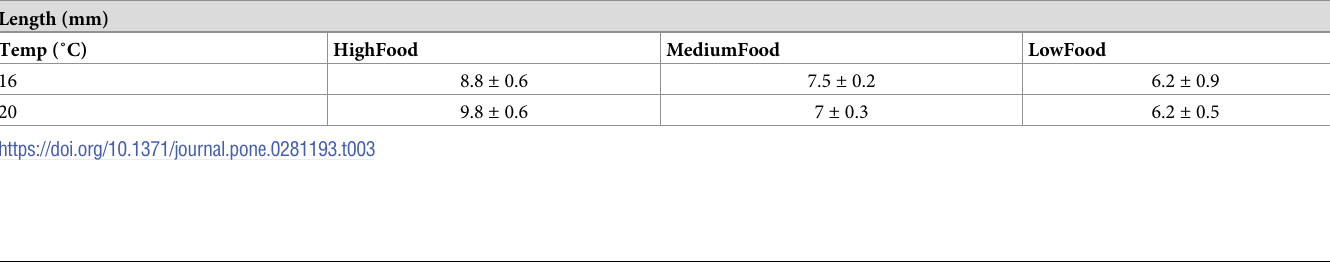
Table 3. Summary of biometric data at the end of the experiment (35